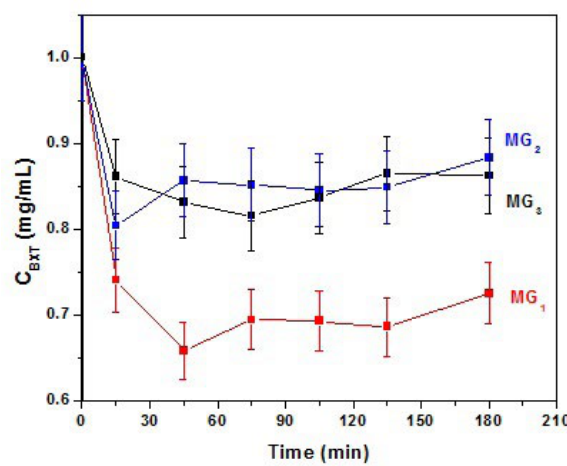
Figure 5. Thermogravimetric curves for functionalized silica samples (MG